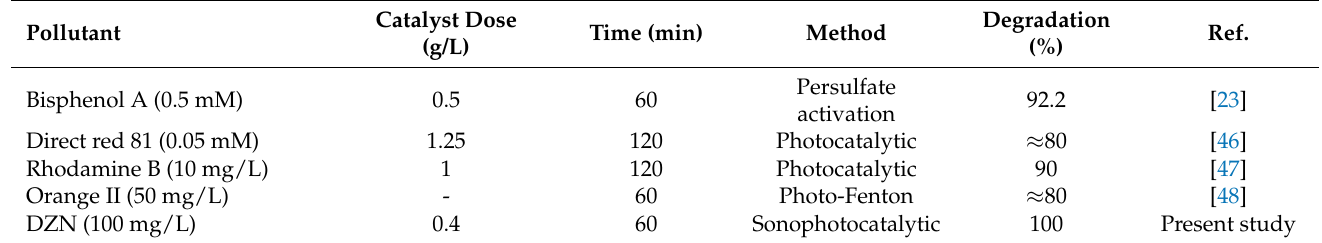
Table 1. The degradation of organic compounds by AOPs based on α -Fe 2 O 3 /g-C 3 N 4